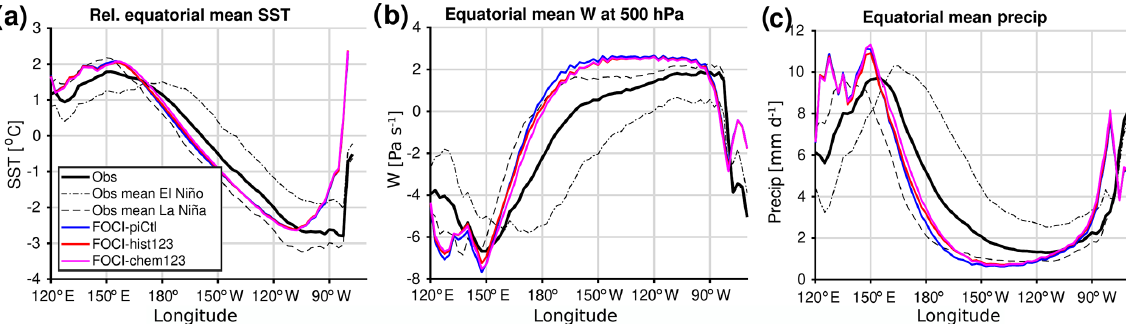
Figure A7. Mean state along the Equator (5 ◦ S–5 ◦ N) for observations/reanalysis data and FOCI experiments (a) for relative SST (i.e., area mean of tropical Pacific is subtracted), (b) vertical wind at 500hPa and (c)